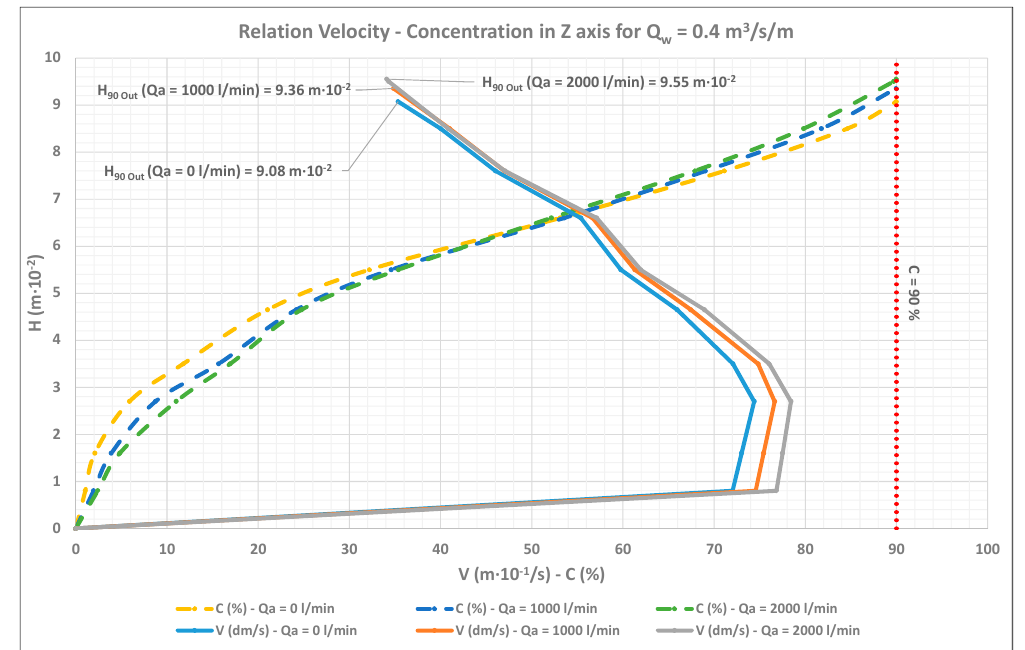
Figure 8. Relation between depth (H) and velocity (V)—Concentration (C) profiles in scenario 2 (Q w = 0.4 m 3 /s/m).